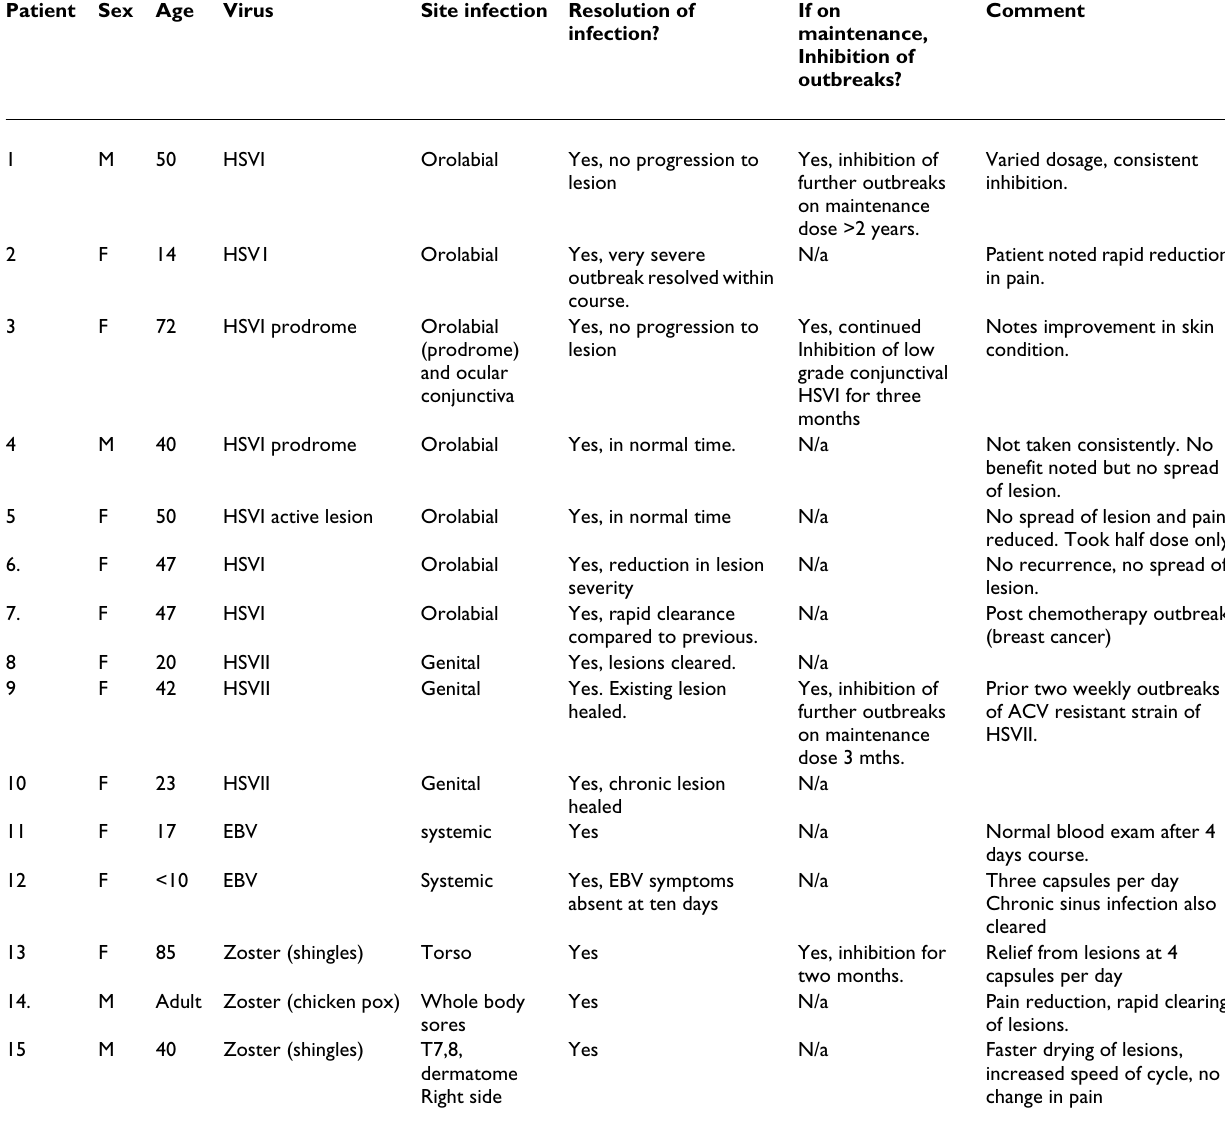
Table 1: Patients with active Herpes infections Patient Sex Age Virus Site infection Resolution of